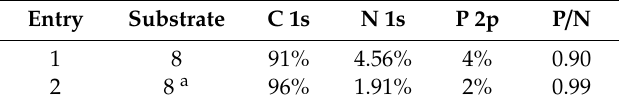
Table 2. X-ray Photoelectron Spectroscopy (XPS) semi-quantitative analysis of 8 dropcasted on Au / mica. Entry